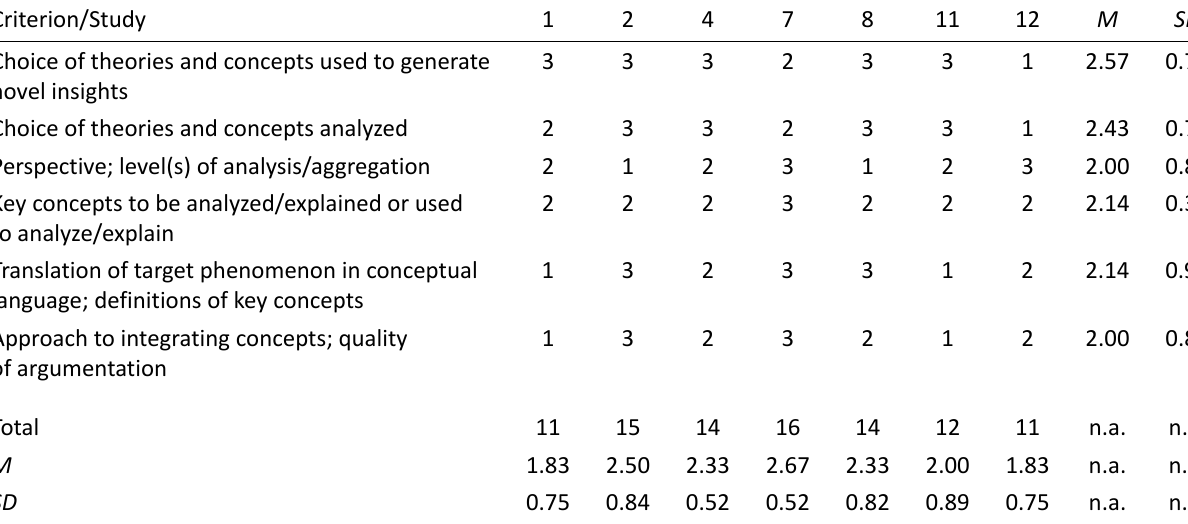
Table 4. Implementation of the research design elements (Jaakkola, 2020) to the sample of conceptual studies ( N = 7). Criterion/Study Choice of theories and concepts used to